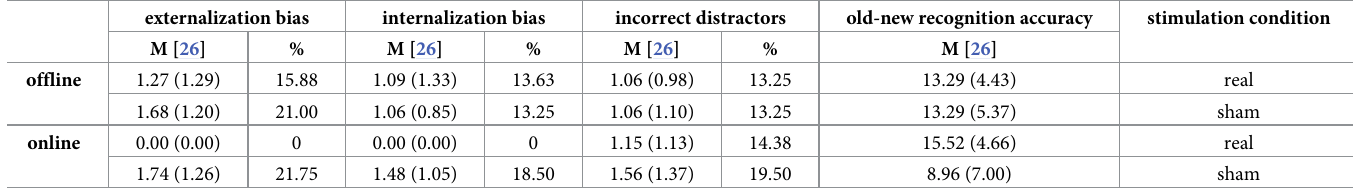
Table 2. Means and standard deviations for total number of errors as well as means of error rates in percent in the Say-Imagine task.